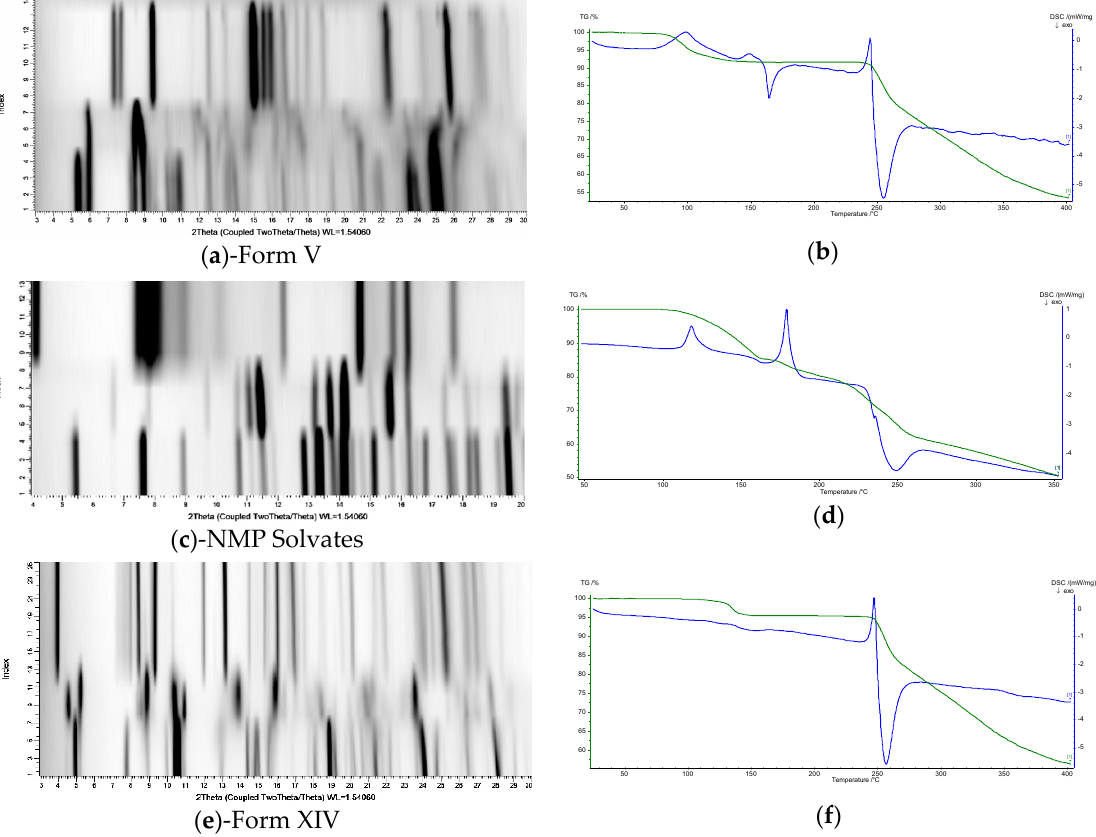
Figure 6. VTXRD and TG/DSC traces of Form V ( a , b ), the original NMP2-rich mixture of NMP1 and NMP2 crystal phases ( c , d ), and Form XIV ( e , f ). Horizontal scale: 2 θ ( ◦ ); vertical scale: progressive number of VTXRD measurements in isothermal conditions (in 20 °C steps each, typically in the 30–240 °C range). Table 6. List of observed 2 θ angles, d-spacings, and relative intensities, jointly with reflection indi- ces, for Eltrombopag Form X.